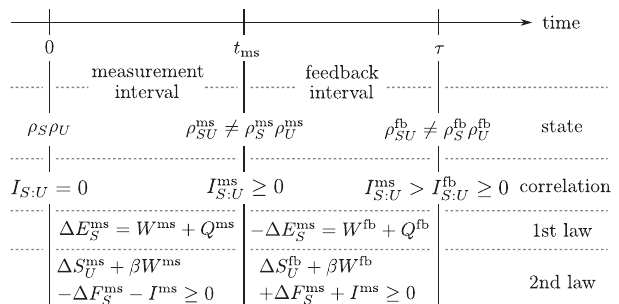
FIG. 4. Overview of the various quantities involved during the measurement and feedback step in the steady-state